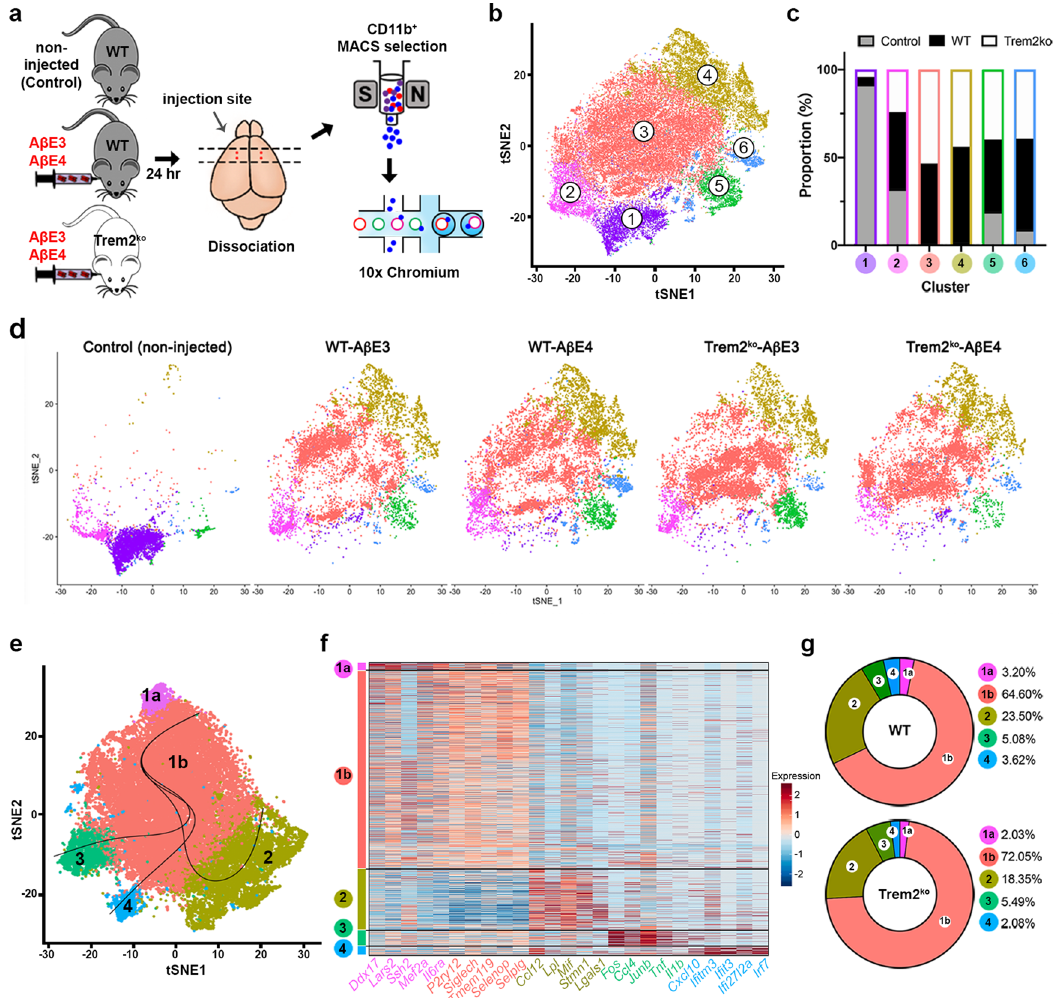
Fig. 5 scRNA-seq data reveal distinct microglial subpopulations in response to A β infusion. a Schematic work fl ow of the experimental strategy for scRNA-seq. Microglia were isolated from WT and Trem2 ko mice injected with A β E3 or A β E4 using CD11b immunomagnetic beads. Microglia from non- injected WT mice were used as control. Isolated cells were immediately applied to the 10x Chromium platform. n = 1 for Control, n = 2 for WT-A β E3, WT- A β E4, Trem2 ko -A β E3, and Trem2 ko -A β E4. b t-SNE plot shows clusters of 39,898 microglial cells after re-clustering using Seurat. c Proportion of cells in each clusters from control, WT, and Trem2 ko microglia. d t-SNE plots of microglia from each experimental condition. e t-SNE plot shows clusters of 36,244 microglial cells after re-clustering of injected samples and inferred trajectories by Slingshot. f Heatmap shows the expression of top fi ve genes in each cluster. g Proportion of cells in each cluster from WT and Trem2 ko